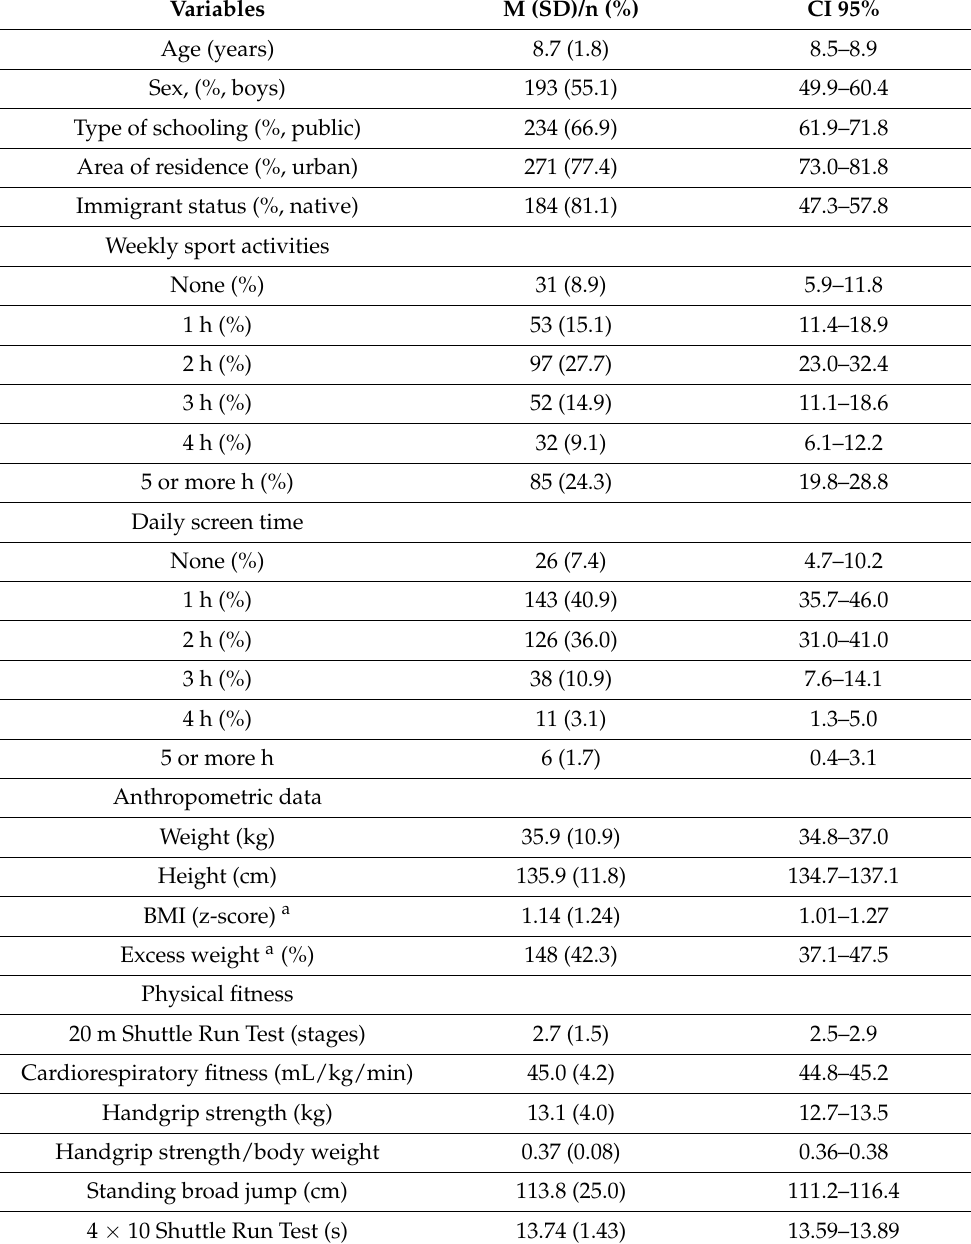
Table 1. Descriptive data of the Spanish schoolchildren analyzed (N =